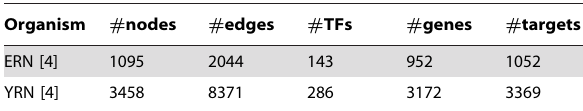
Table 1. Regulatory networks.